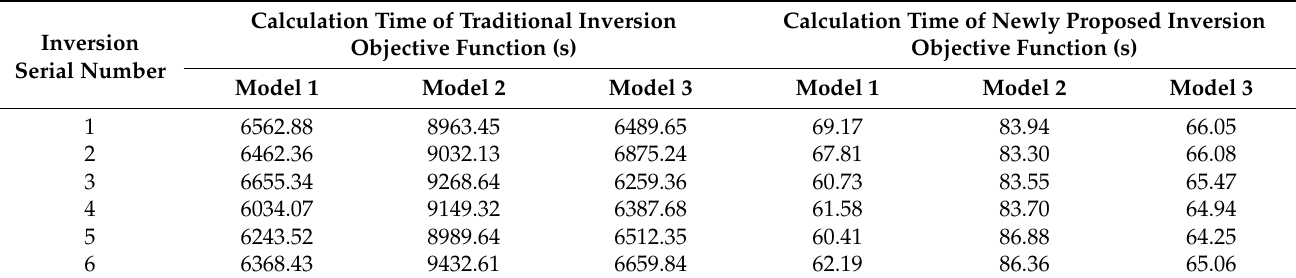
Table 4. Calculation time of inversion multi-order dispersion curves based on different inversion objective